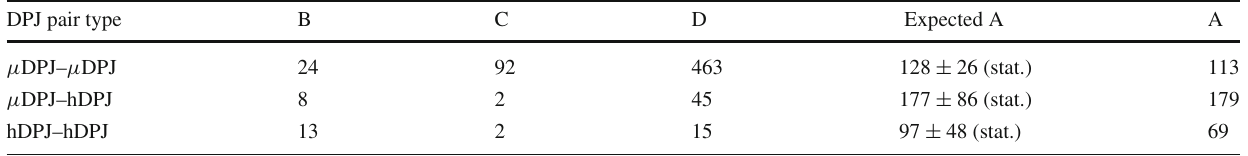
to zero. Both the statistical and systematic uncertainties in the back- ground expectations are given. The expected contribution from cosmic rays is included in all regions